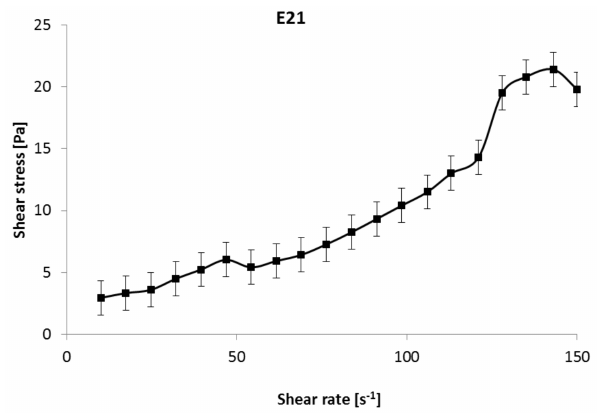
Figure 3. Flow curve of alloy E21 for 50% of the solid phase.